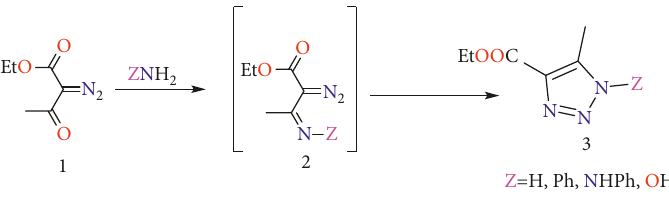
Scheme 2: (1H-) and (2H-)1,2,3-triazole tautomers.